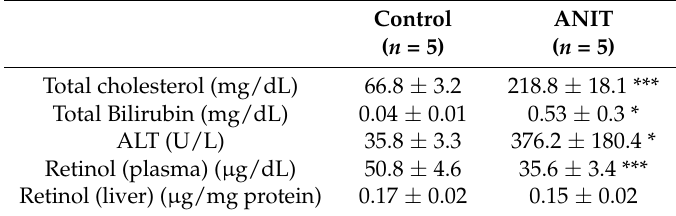
Table 1. Biochemical profiles and retinol status between control and ANIT rats.